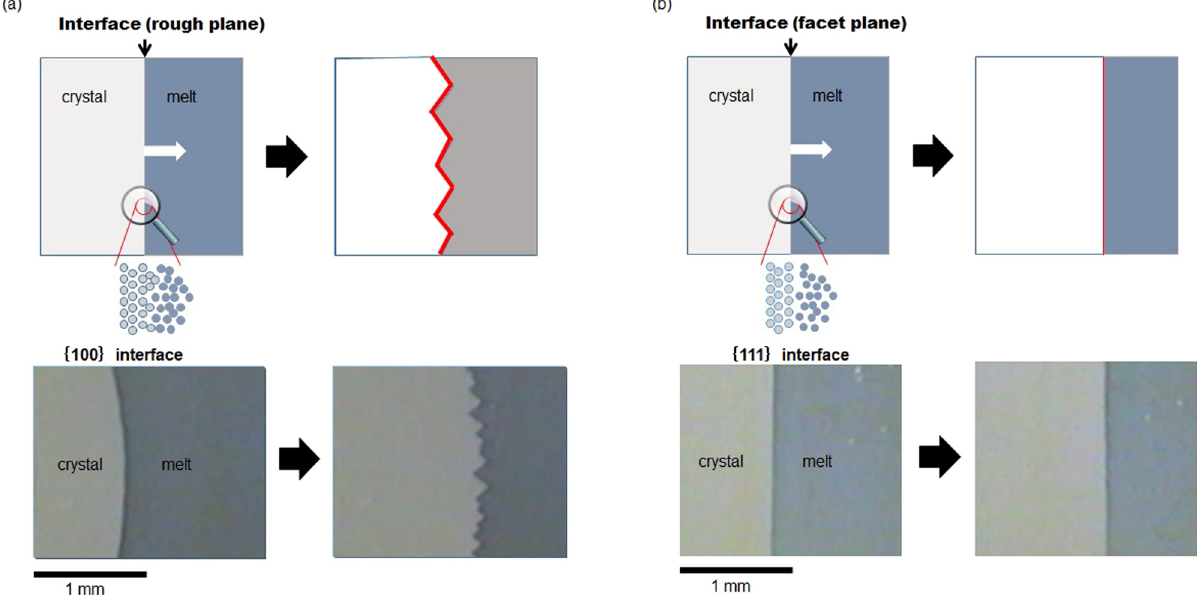
Figure 6: Transformation of microscopic interface shape for atomically rough and smooth planes [ 90 ] : ( a ) the case of a rough plane. The fl at interface is transformed to a zigzag interface with increasing growth rate due to the interface instability and ( b ) the case of a smooth plane ( facet plane ) . The fl at interface is maintained even at a higher growth rate.